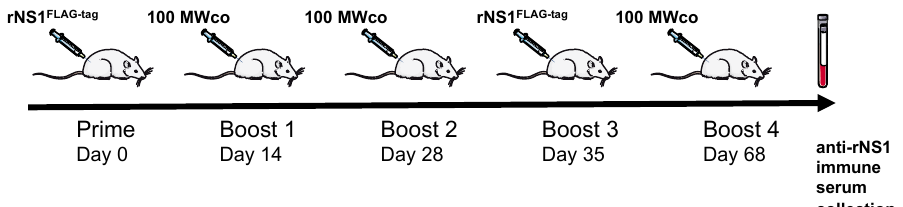
Figure 4. Sequence of rat immunization with recombinant ZIKV NS1 protein. Adult female Wistar rat was subcutaneously immunized with purified rNS1 FLAG-tag . After the prime, animal was boosted with rNS1 into the 100 MWco fraction of Vero/ZIKV.NS1 cell supernatants. A second inoculation of purified rNS1 FLAG-tag was performed at Day 35. Whole blood was collected 83 days after the prime.